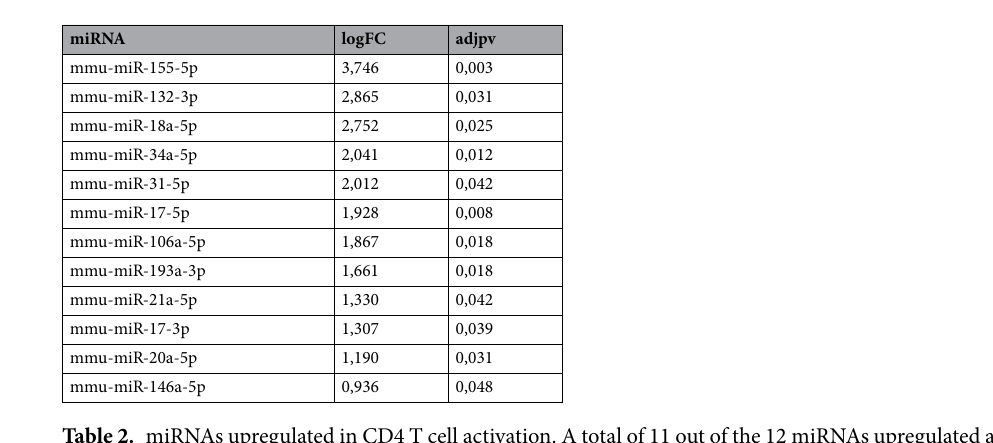
Table 2. miRNAs upregulated in CD4 T cell activation. A total of 11 out of the 12 miRNAs upregulated after CD4 T cell stimulation by cDC-OVA are predicted to be targeting pik3r1. The only miRNA not predicted to target is presented in